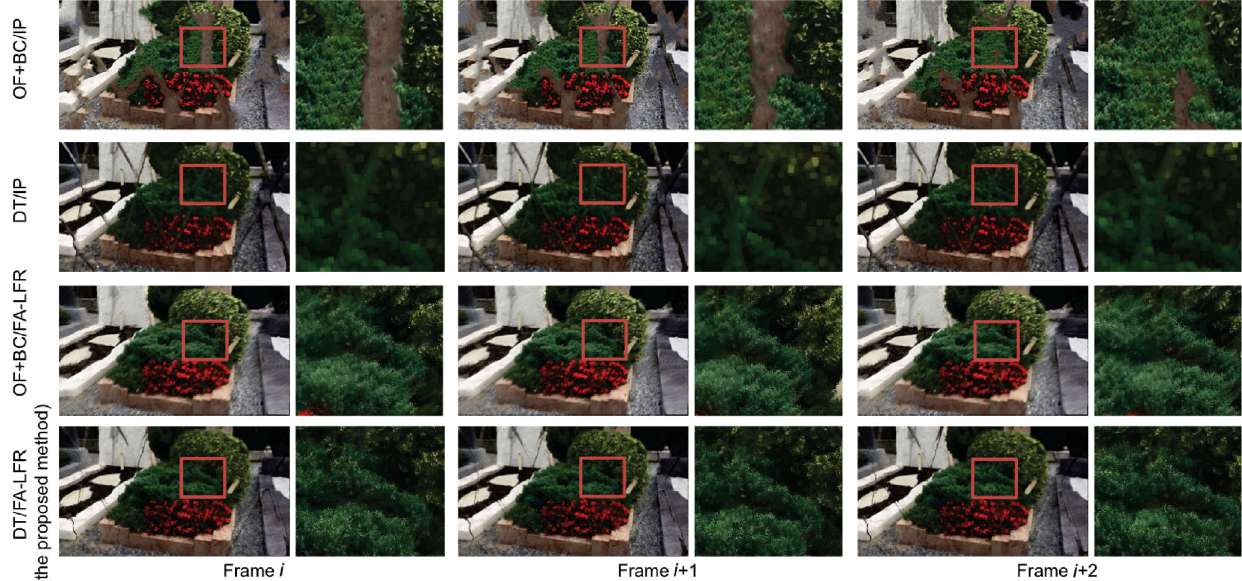
Fig. 12 Comparison of background restoration for consecutive frames of Scene 5.